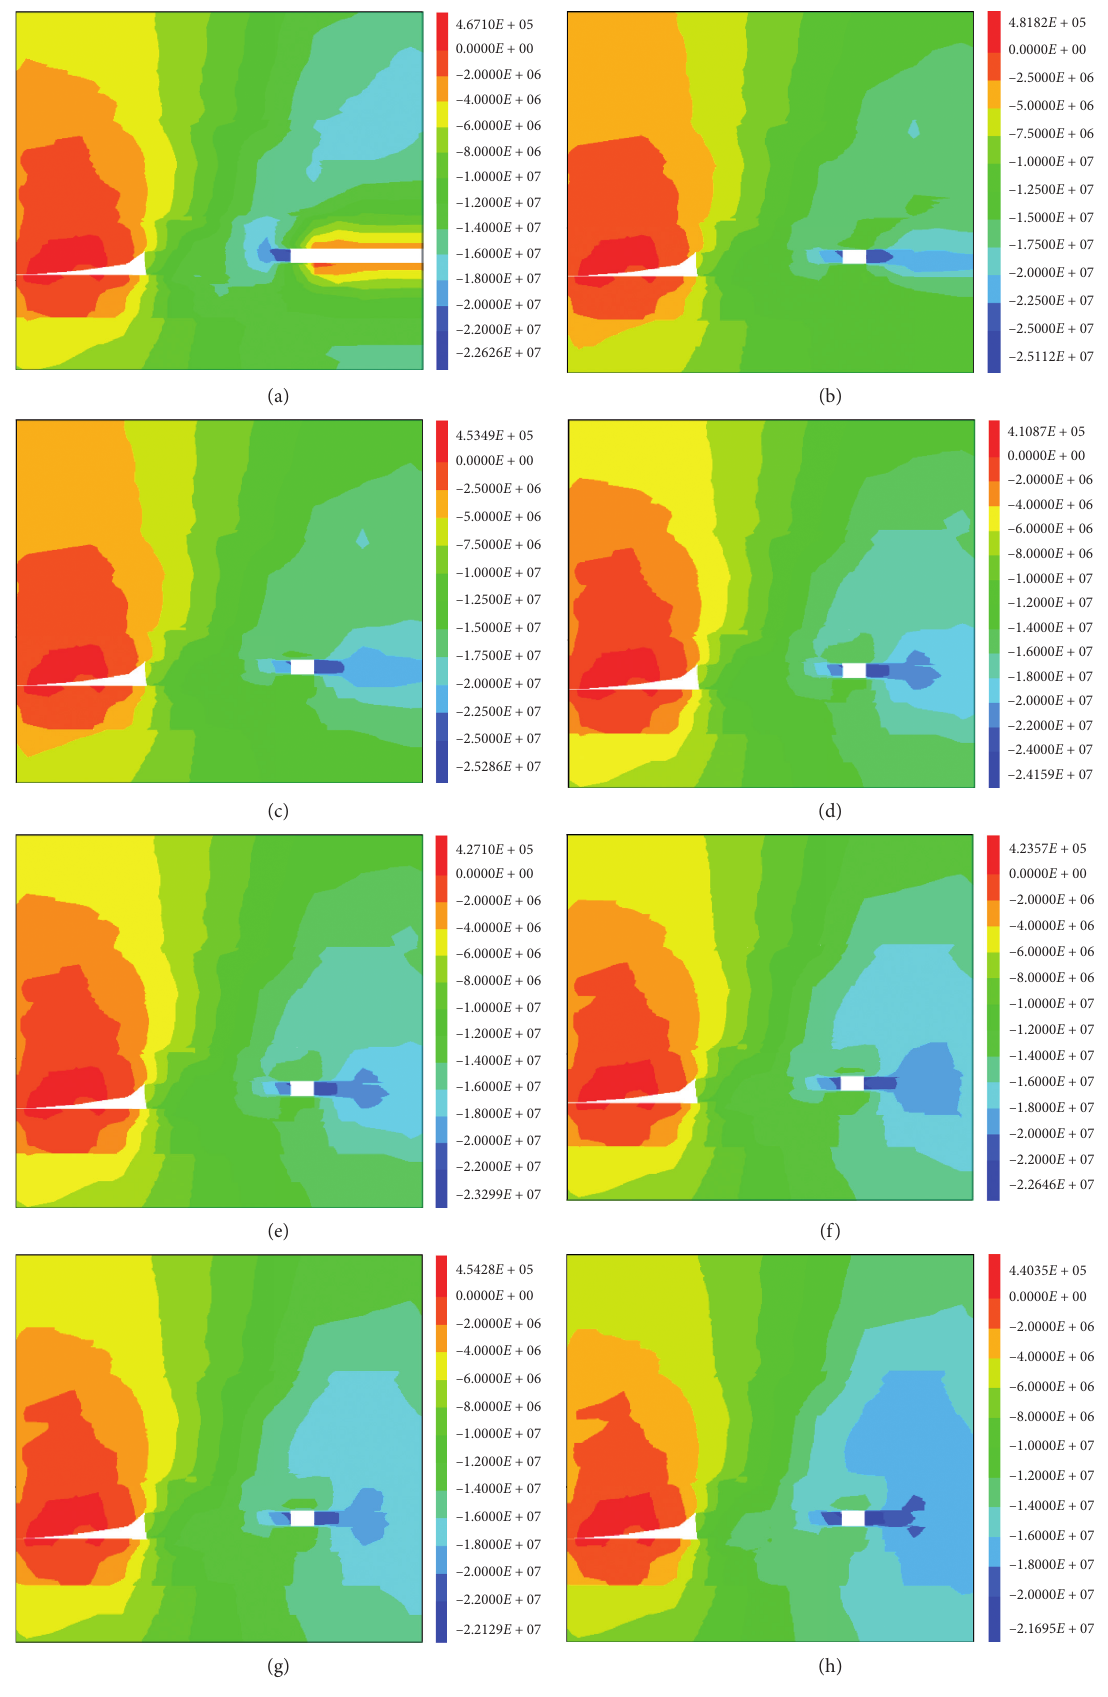
Figure 4: Vertical stress nephogram of auxiliary transport roadway: (a) 0m, (b) 5m, (c) 10m, (d) 15m, (e) 20m, (f) 25m, (g) 30m, and (h) 35